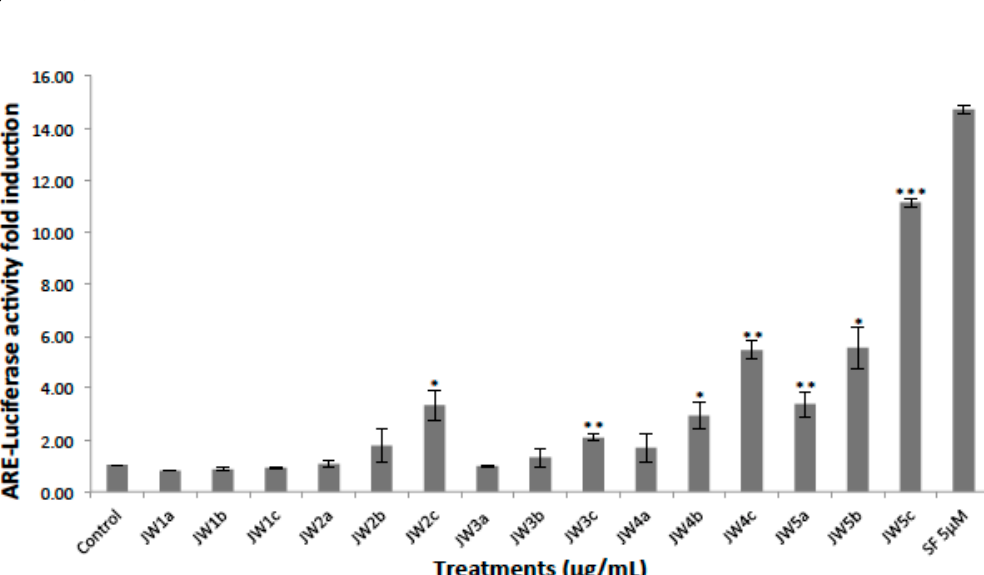
Figure 4. The effect of five fractions on ARE-luciferase reporter activity in ARE reporter-HepG2 cells. Cells were seeded in 96-well plates at a density of 4 × 10 4 cells/well and incubated for 24 h. The cells were further treated with 20, 40, 80 μ g/mL concentrations of each fraction for additional 24 h. The negative control cells were treated with 0.2% DMSO, and positive control cells were treated with 5 μ M DL-sulforaphane (SF). Luciferase activity was determined. Mean ARE-luciferase reporter activity represents the average of three-independent experiments ± S.E.M. * p < 0.05; ** p < 0.01, *** p < 0.001. ( a : 20 µ g / mL; b : 40 µ g / mL; c : 80 µ g / mL).